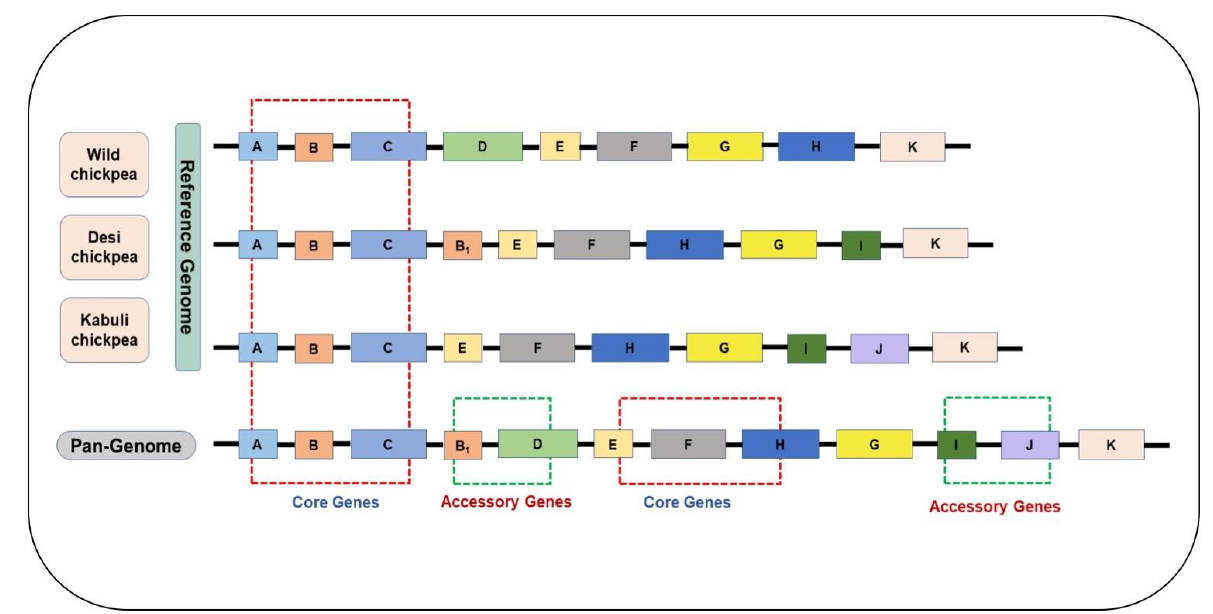
Figure 1. Phylogenetically diverse accession selected for construction of pangenome that contains core genes and accessory genes. Pangenome contains all the possible structural variation that may occur during evolution, such as B 1 : copy number variation, D: deletion variation, I and J: insertional variation, and G: transposable element.